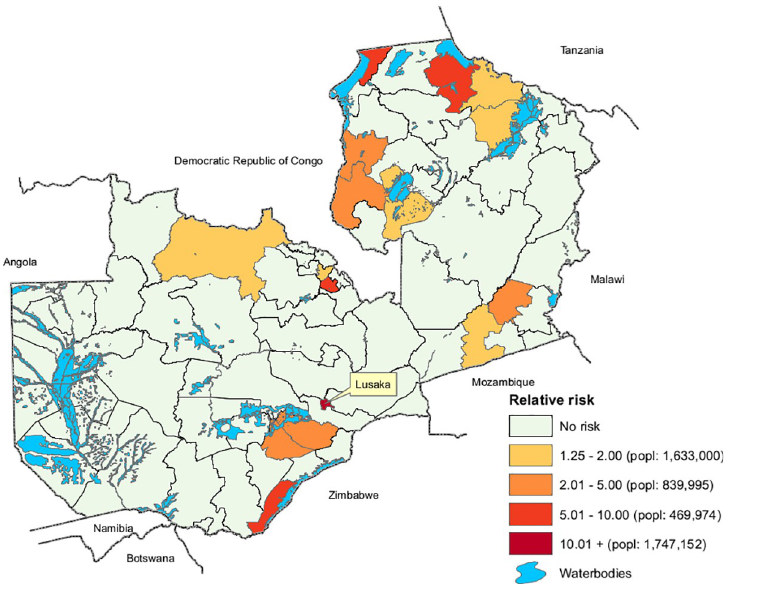
Fig 3. Spatiotemporal hotspots of cholera in Zambia, 2008–2017.